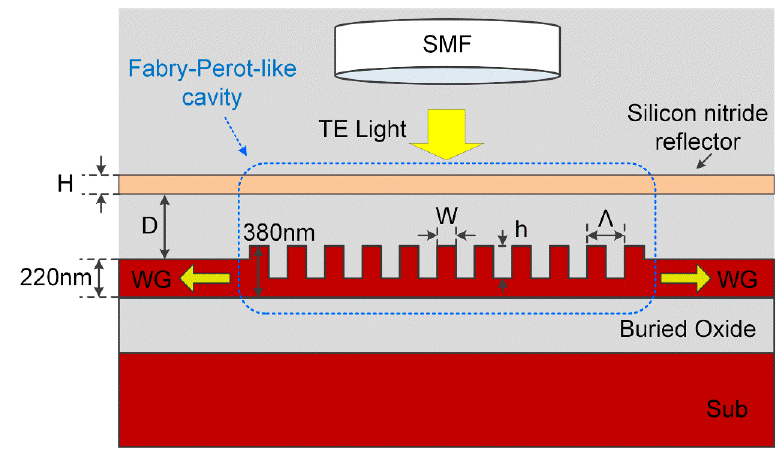
Figure 2. Schematic diagram of the device configuration. The Si 3 N 4 layer and the grating, together form a Fabry-Perot-like cavity to reduce the up-reflection, thus enhancing the coupling efficiency (CE).